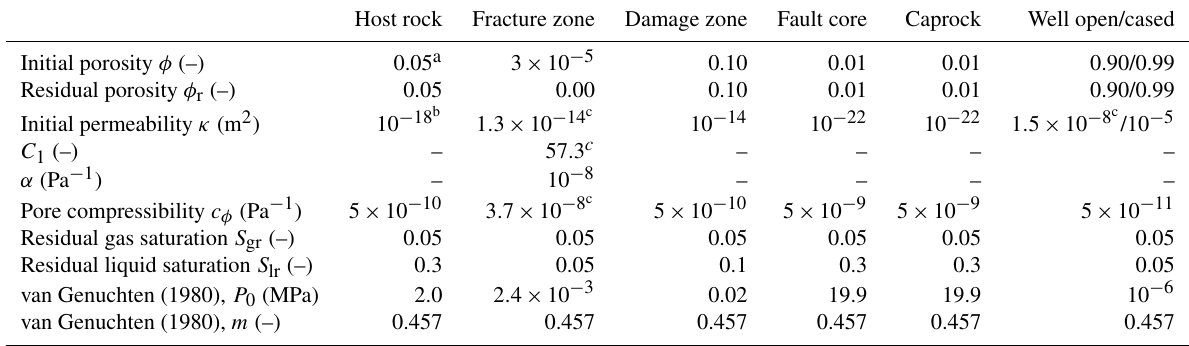
Figure 5. Schematic of the 3D numerical model: (a) slice at y = 0km (along profile A–A (cid:48) in Fig. 2). The well is indicated by the blue (cased section) and red lines (open section). (b) Entire 3D model along the strike of the fracture zone and fault (along profile B–B (cid:48) in Fig. 2). The dark green arrows indicate the orientation of the mean stress field used for the TOUGH2-seed simulations. Table 1. Predefined and calibrated hydraulic parameters of the numerical model. Host